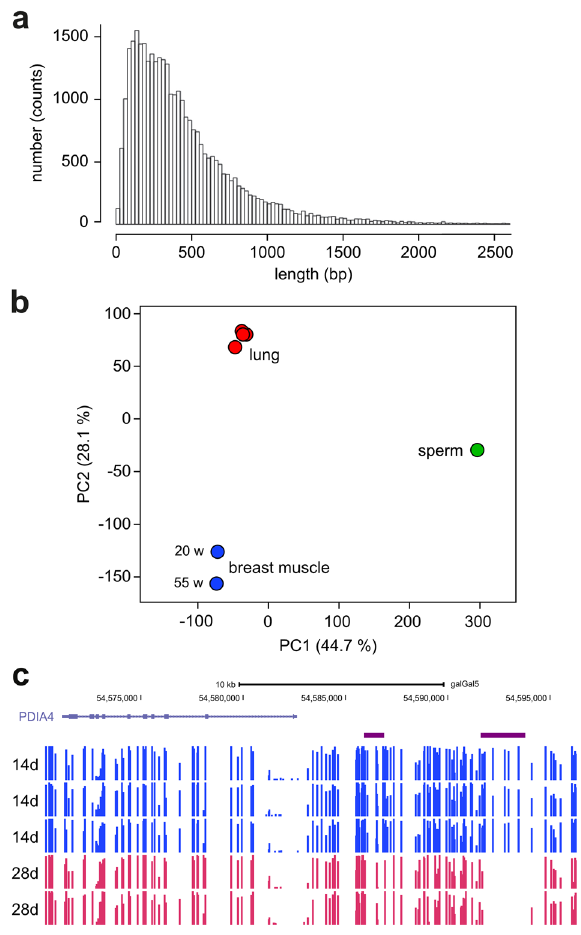
Fig. 3 Identi fi cation of low-methylated regions (LMRs) in the chicken methylome. a Size distribution of chicken LMRs. b Principal component analysis of LMR methylation patterns from different tissues, strains, and age groups. c Age-related differential methylation of LMRs in the jejunum of broiler chickens. Representative methylation tracks for the PDIA4 gene in d14 (blue) and d28 (crimson) samples. The position of LMRs is indicated by purple horizontal bars. Note the pronounced differential methylation between d14 and d28 for the rightmost